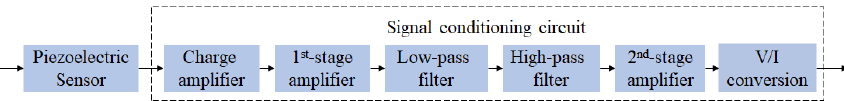
Figure 1. System architecture for the acoustic sensor-based leak detection.